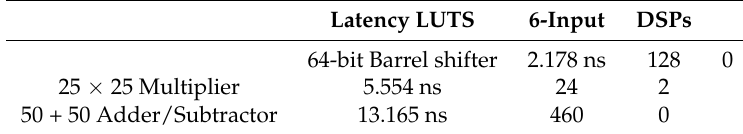
Table 4. Latency and hardware utilization of the main components of